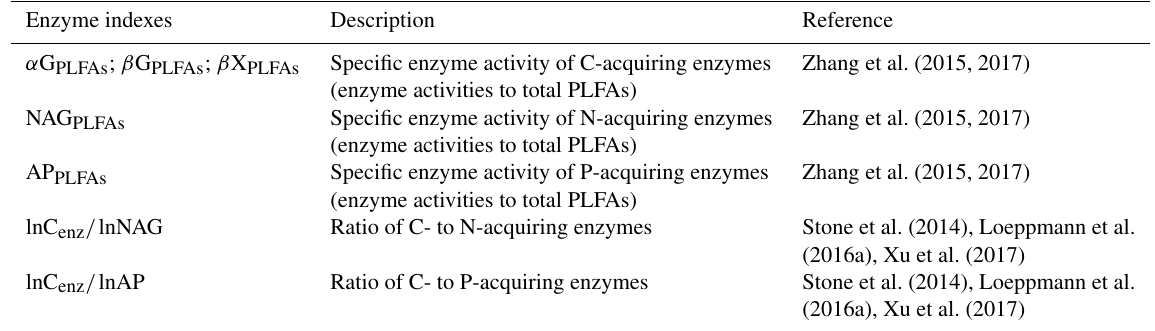
Table A2. Enzyme indexes: the potential enzyme activity and the total PLFA contents were used to calculate different enzyme in- dexes. α -1,4-glucosidase ( α G), β -1,4-glucosidase ( β G), and β -1,4-xylosidase ( β X) represented C-acquiring enzymes, whereas β -1,4-N-